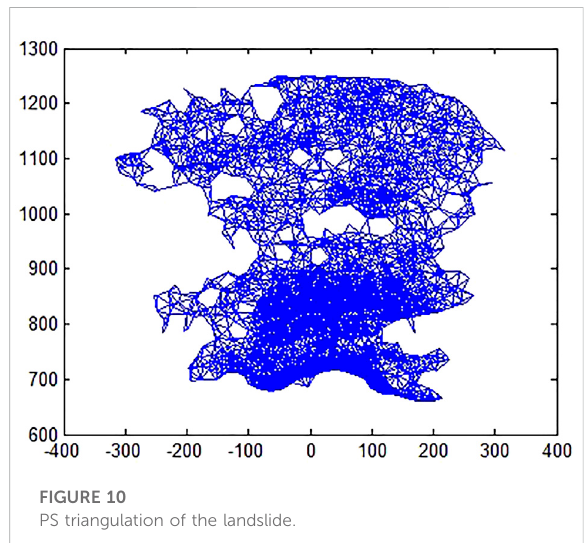
FIGURE 10 PS triangulation of the landslide.